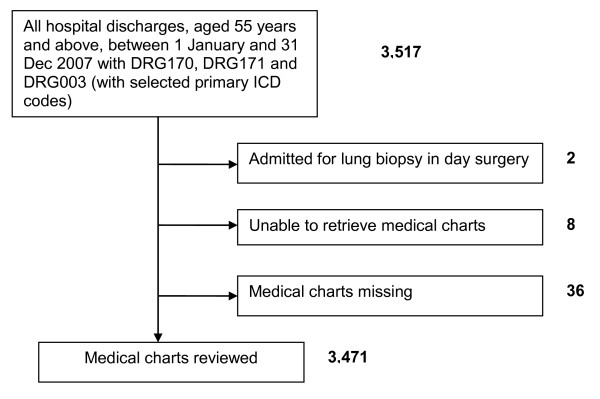
Study flow diagram.